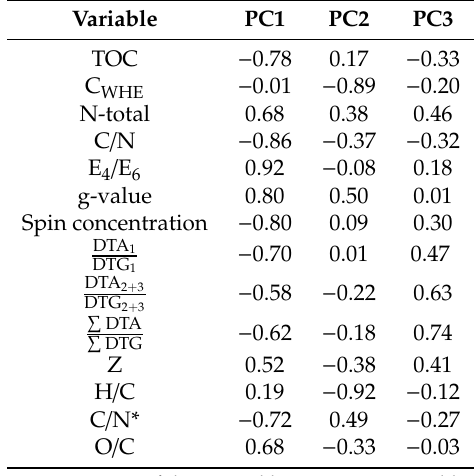
Table 11. Factor loadings and explained variance of three principal components in PCA. Variable PC1 PC2 TOC −